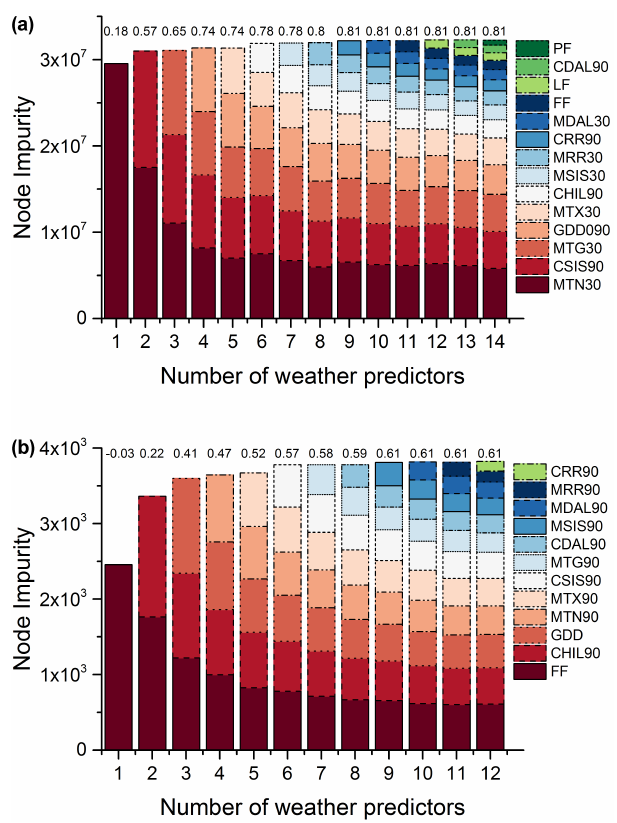
Figure 4. Relative importance of each independent variable in pre- dicting phenology interannual variation in Europe. Different models derived from the feature selection approach are represented in each column. Numbers given over each column represent the coefficient determination of each model. Plots at the top and bottom represent the spring (a) and autumn (b) interannual variation in LSP, respec- tively. The names of predictors use the following notation: prefixes M and C represent the mean and cumulated functions; TX, TN and TG: maximum, minimum and average temperature, respectively; PP: precipitation; SIS: surface incoming shortwave radiation; DAL: surface radiation daylight; GDD: growing degree days; CHIL: chill- ing requirements; FF, LF and PF: first, last and period of freeze,